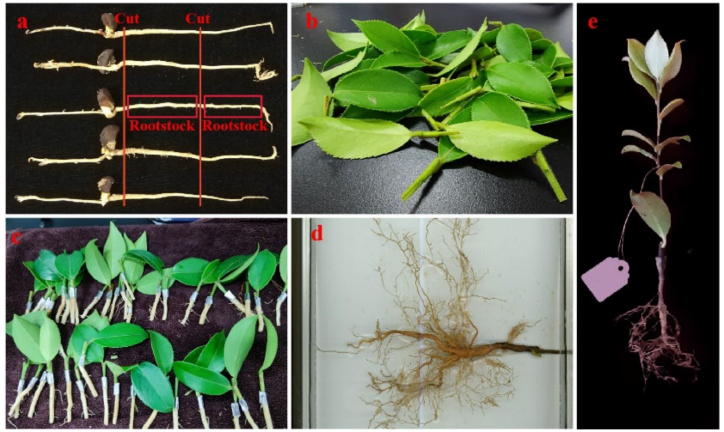
Figure 1. C. oleifera nurse seedling grafting and the root morphology. ( a ) Rootstock; ( b ) Scion; ( c ) Grafted combination; ( d ) Root morphology for the grafted C. oleifera ; ( e ) Grafted C. oleifera seedlings with two